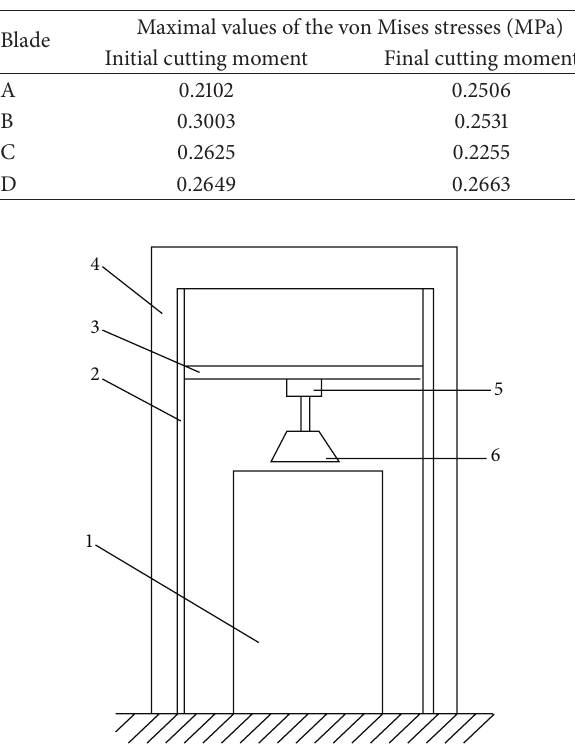
Figure 5: A schematic diagram of the testing device.